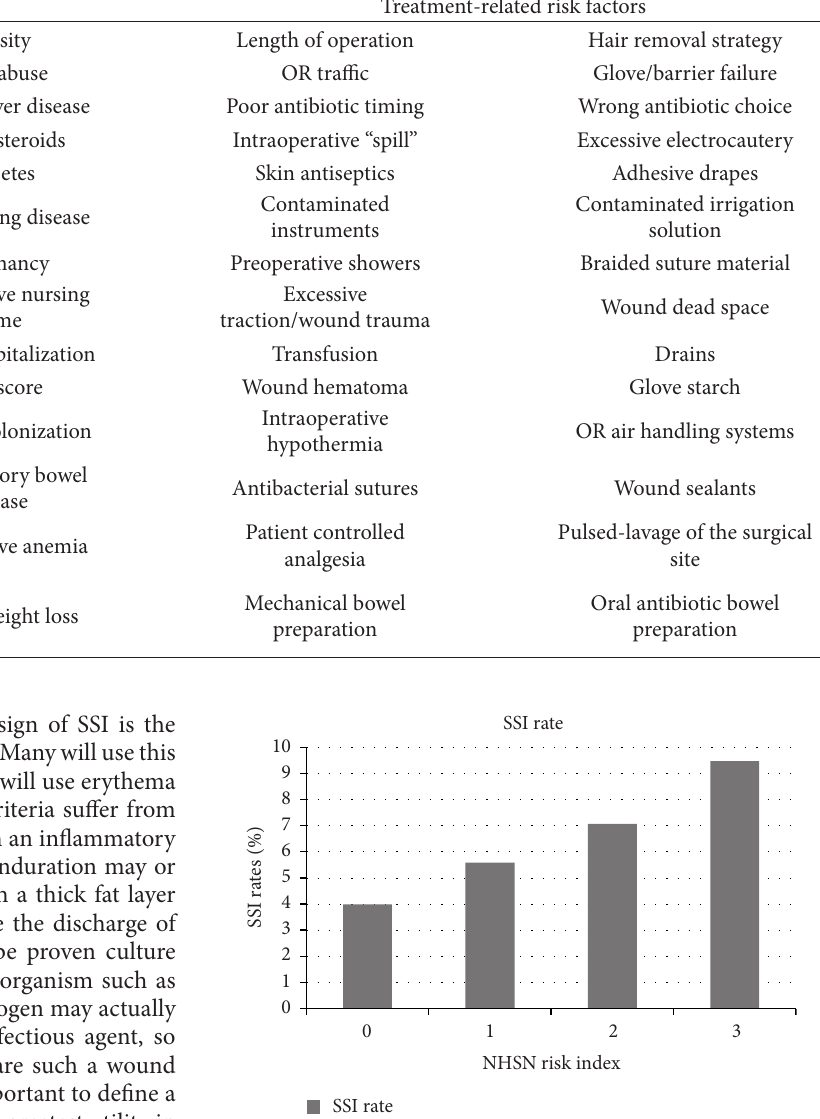
Figure 2: This illustrates the reported rates of SSI following colectomy for each of the NHSN index risk